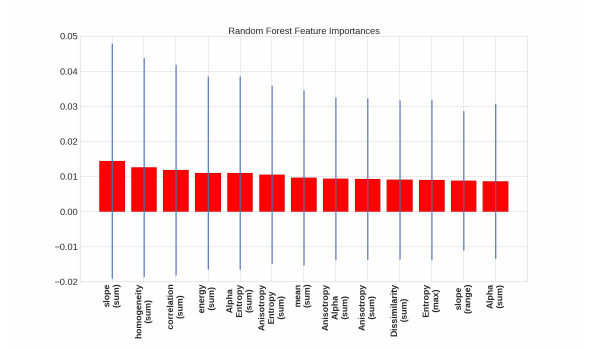
Figure 7: Random forest feature